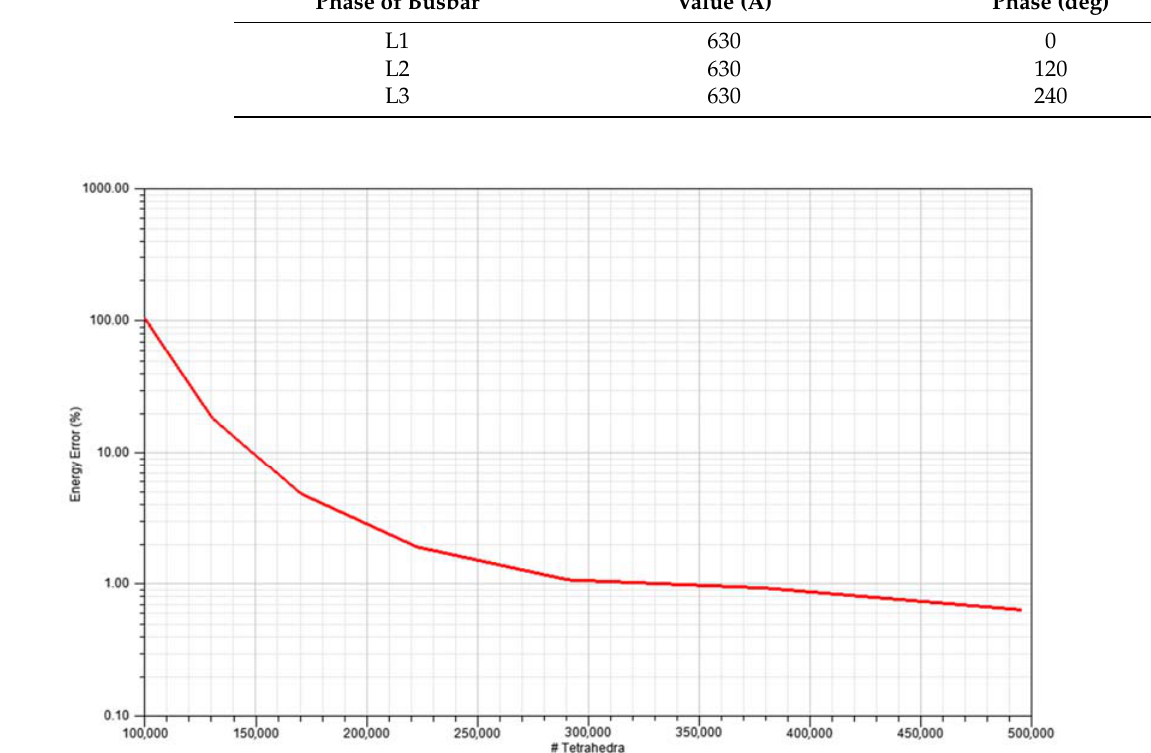
Figure 5. Convergence plot—energy error in relation to the number of “Tetrahedra”.